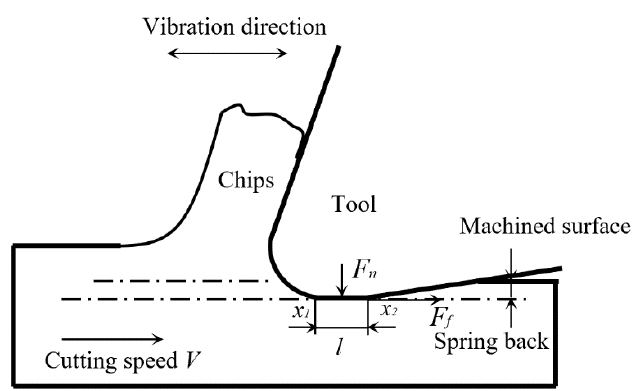
Figure 13. Layout of contact length between the workpiece and the tool in vibration-assisted micro milling.